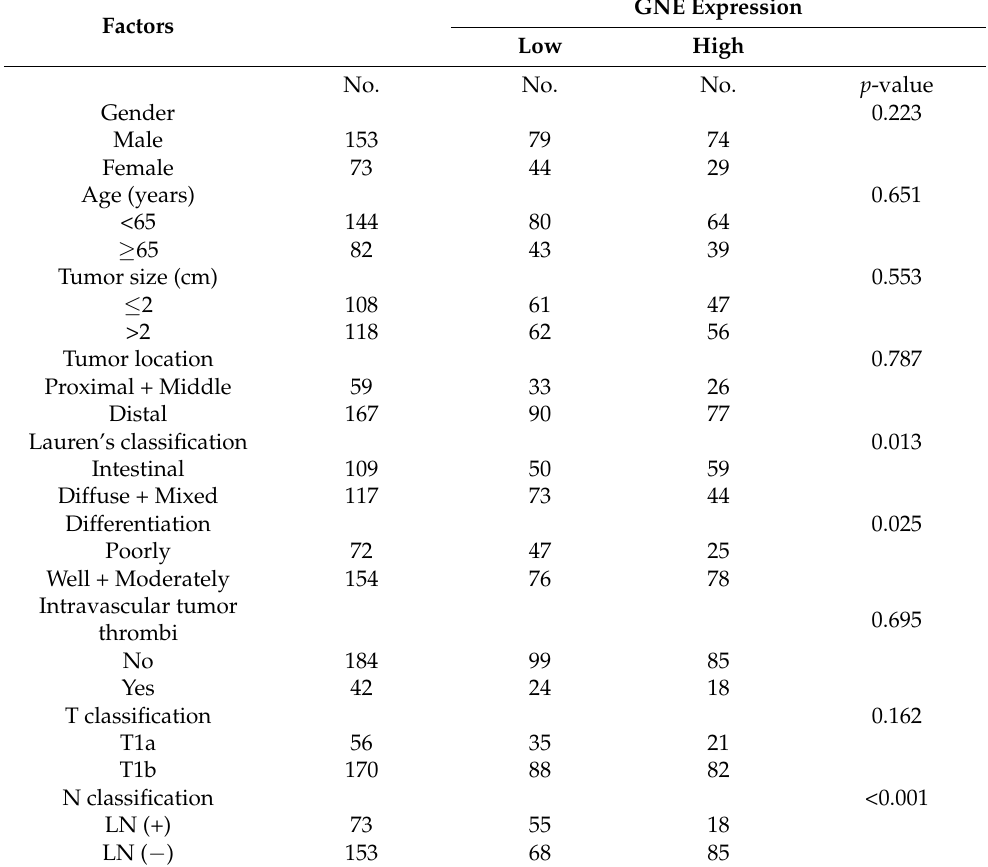
Table 1. Correlation between intratumoral GNE expression and clinical characteristics of early gastric